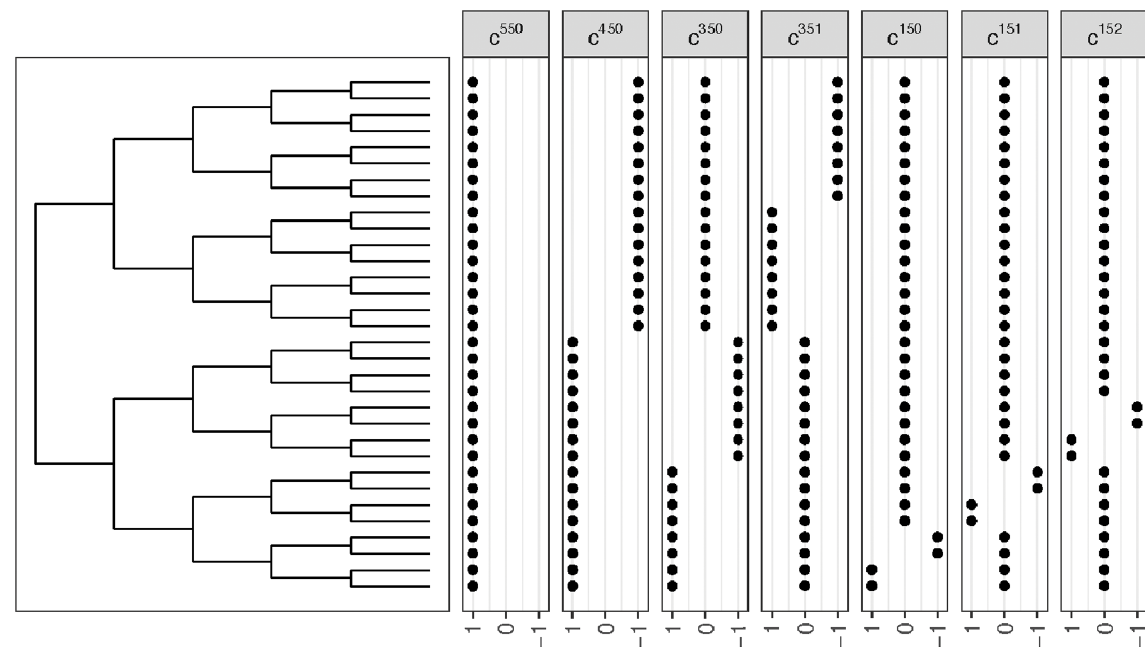
Fig 4. Illustration of the vectors c ijk for j = 5 and various values of i